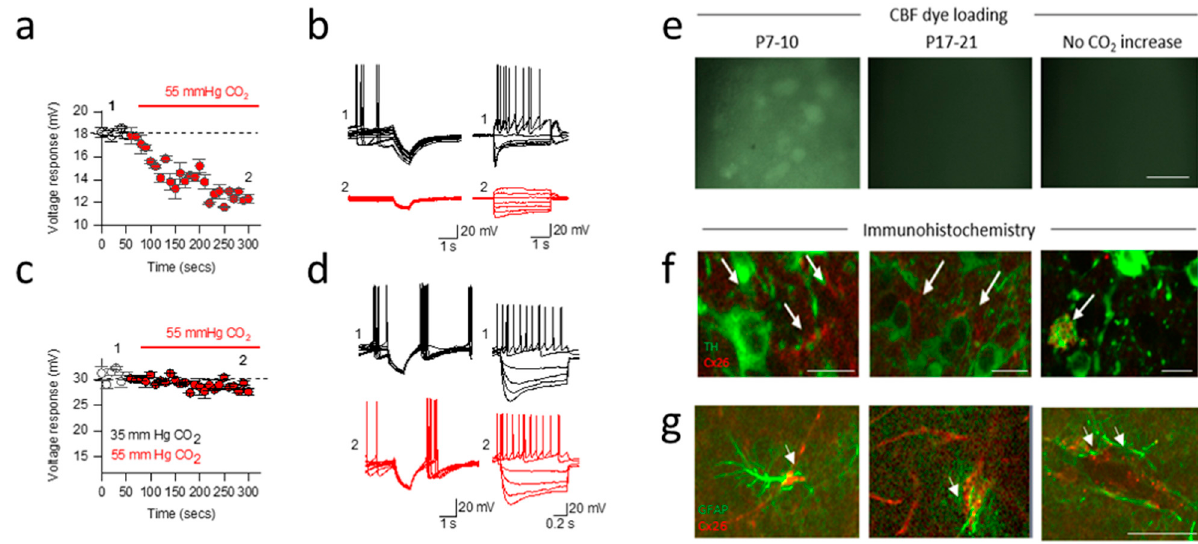
Figure 3. CO 2 sensitivity of dopaminergic neurons in the substantia nigra alters across development. ( a ) Changes in voltge responses to hyperpolarising current steps for a neuron from a P7-10 mouse when CO 2 was increased from 35 to 55 mmHg (red). ( b ) Associated voltage traces (40 superimposed traces) in response to step currents (from − 200 pA to 50pA) at the indicated time points from a. ( c ) There was no significant change in the voltage response to hyperpolarising current steps in a dopaminergic neuron from a P17-21 mouse when CO 2 was changed from 35 to 55 mmHg. ( d ) Associated voltage traces (40 superimposed traces) and voltage responses to step currents at indicated time points from c. ( e ) Carboxyfluorescein (CBF) dye loading following hypercapnia (55 mmHg CO 2 ) in P7-10 mouse slices. No dye loading occurred if CO 2 was not changed or if CO 2 was increased in P17-21 slices, scale bar = 50 µm. ( f ) Immunofluorescent staining of P7-10 SN for Cx26 (red, arrows) in TH+ neurons (green) in single optical planes, scale bar = 20 µm. ( g ) Immunofluorescent staining of P17-21 SN for Cx26 (red, arrows) in glial fibrillary acidic protein (GFAP; green) in single optical planes, scale bar = 50 µm. Adapted from [17].